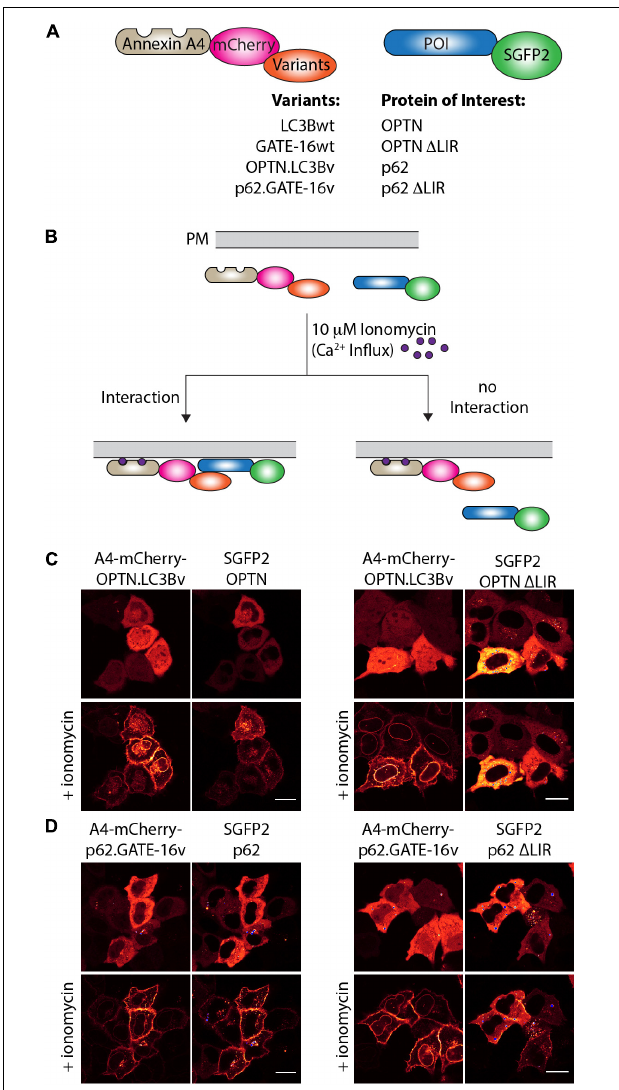
FIGURE 3 | OPTN.LC3Bv and p62.GATE-16v bind their cognate LIR peptide in cells. (A) Constructs tested in annexin A4 translocation assays. Annexin A4 (blue) is fused to mCherry (magenta) and the corresponding LC3Bwt, GATE-16wt or variant (orange). Protein of interest (POI) is fused to SGFP2 (green). (B) Annexin A4 assay principle. Addition of ionomycin leads to Ca 2 + influx, resulting in annexin A4 translocation to the plasma membrane. In case the LC3B, GATE-16wt or variant interacts with the POI, green and red fluorescence co-localize at the plasma membrane. In case there is no interaction only the red fluorescence localizes to the plasma membrane. (C) Annexin A4 translocation in transfected HeLa cells transfected with OPTN.LC3Bv and SGFP2-OPTN or SGFP2-OPTN (cid:49) LIR upon ionomycin addition. (D) Annexin A4 translocation in transfected HELA cells of p62.GATE-16v and SGFP2-p62 or SGFP2-p62 (cid:49) LIR upon ionomycin addition. In (C) and (D) , bar represents 20 µ